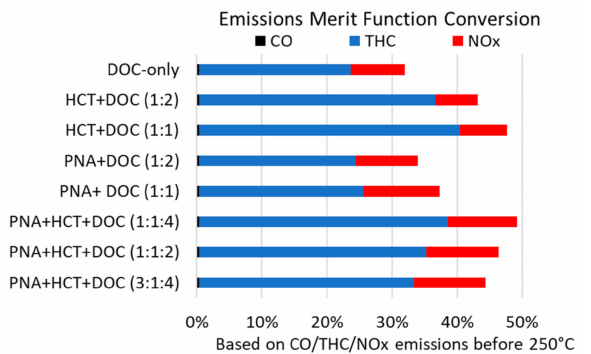
Figure 5. Emissions merit function conversion for a series of physical mixture reactor beds calculated from Equation (3) that represents the portion of the emissions that are converted up to 250 ◦ C. Contributions from ( (cid:4) ) CO, ( (cid:4) ) THC, and ( (cid:4) ) NOx are shown as a portion of the total for each graph. Ratios in parentheses represent the mass ratio of the different components in the sample,